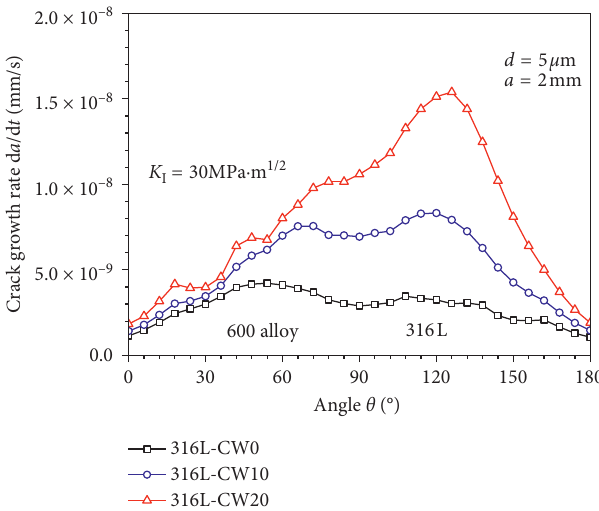
Figure 14: Effect of cold working on the crack growth rate of the heat-affected zone.